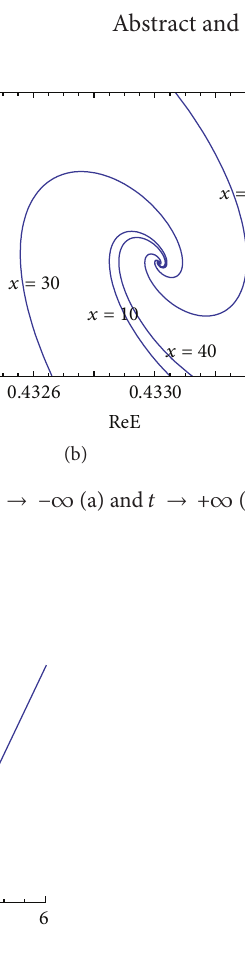
Figure 3: One heteroclinic orbit for Schr¨odinger-Boussinesq equation as 𝑥 = 0